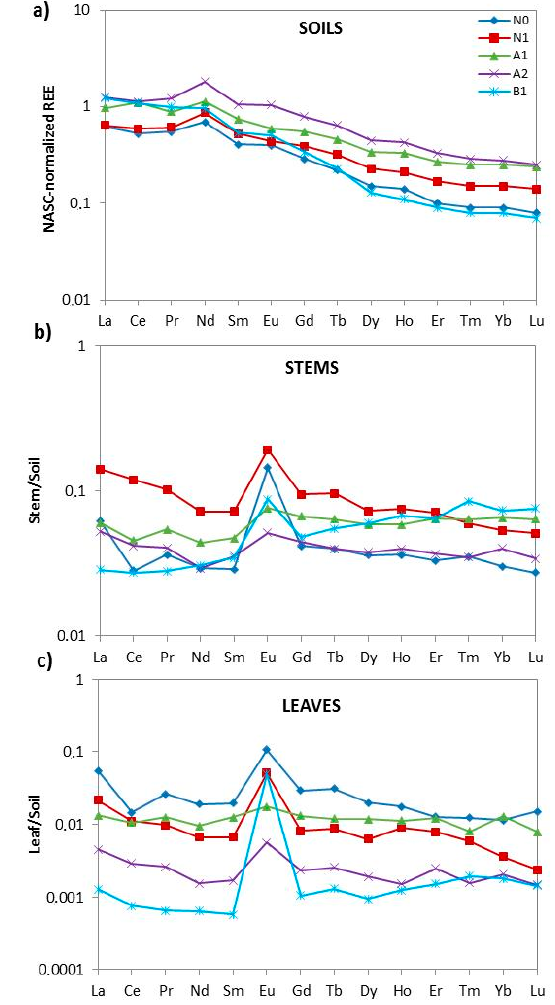
Figure 3. ( a ) NASC-normalized rare earth element (REE) patterns of the five investigated soil samples and soil-normalized REE patterns of ( b ) stems and ( c ) leaves of the plant Equisetum arvense L.